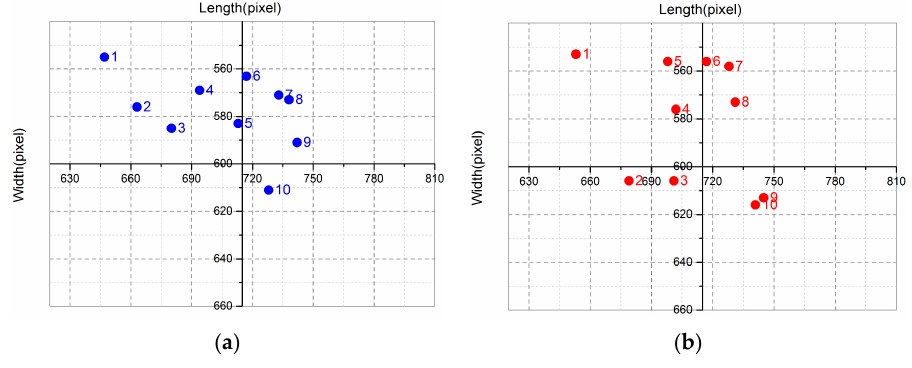
Figure 13. Changes of island positions at the center of the growth furnace crucible: ( a ) observed positions; ( b ) the positions resulting from image processing. Table 2. Comparison of coordinates between observed and measured positions (i.e., the results of image processing).